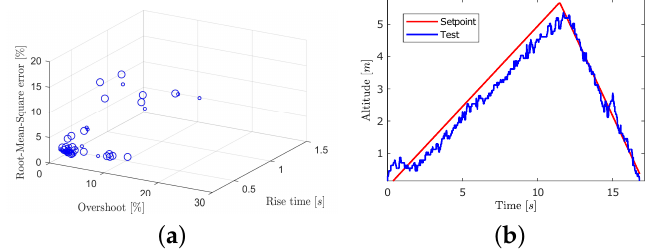
Figure 13. ( a ) Pareto front altitude. ( b ) Altitude axis response